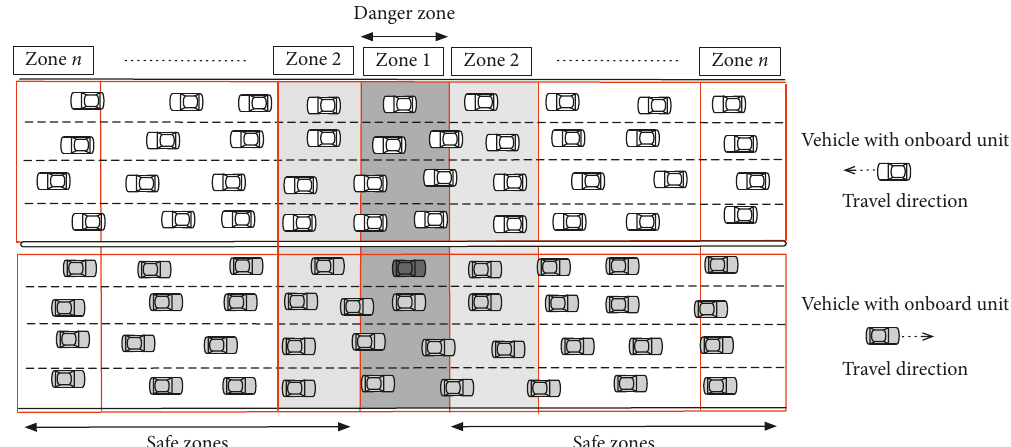
Figure 2: Concept of zones based on velocity of neighboring vehicles and road configuration.